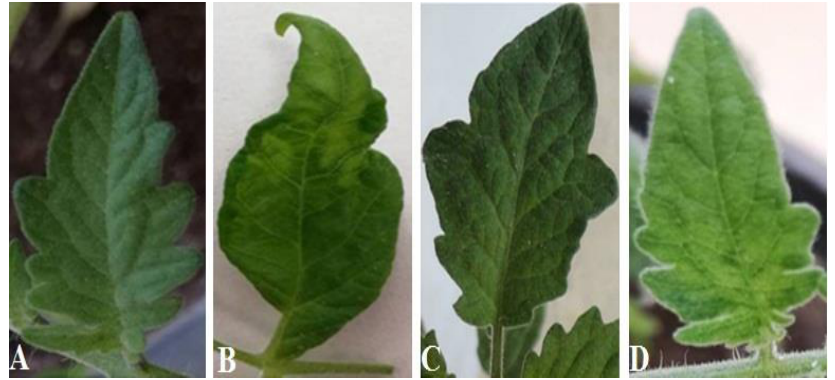
Figure 1. Disease symptoms on tomato leaves infected with tobacco mosaic virus (TMV) at 21 days post-inoculation. ( A ) Mock-treated plants. ( B ) Plants inoculated with TMV only. ( C ) Plants treated with Streptomyces cellulosae isolate Actino 48 only. ( D ) Plants treated with Actino 48 before inoculation with TMV (48 h).